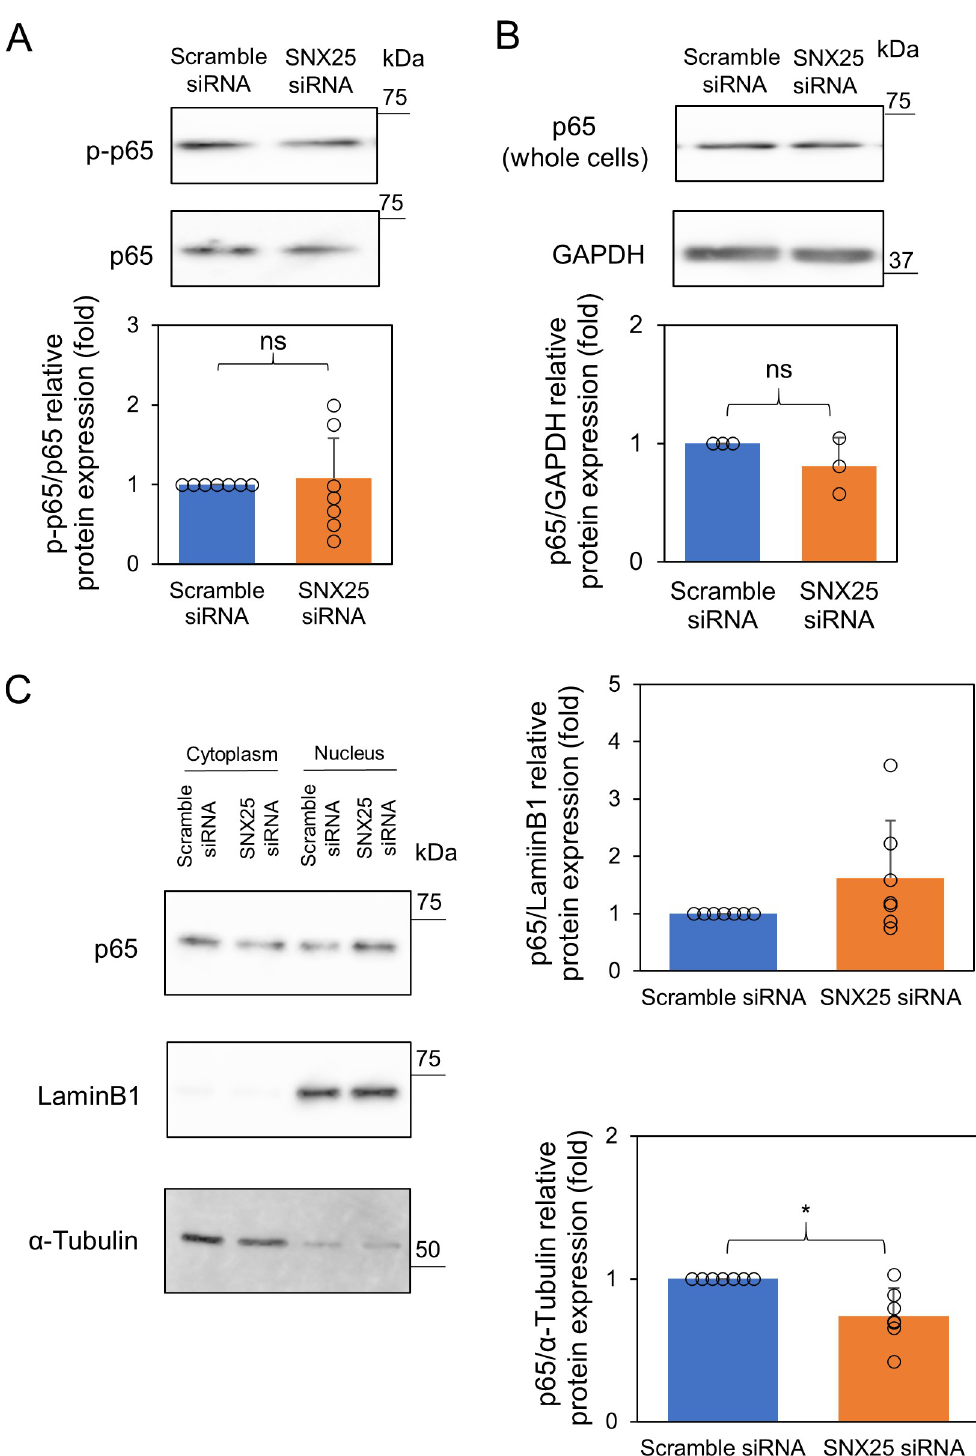
Fig 4. Activation of NF- κ B signaling pathways in SNX25 knockdown RAW 264.7 cells. (A) RAW 264.7 cells were stimulated with LPS (1 μ g/ml) for 10 min. p-p65 expression was analyzed by Western blotting. p65 was used as a loading control. Circles indicate the individual experimental values. Data are expressed as means ± SD. n = 7. (B, C) RAW 264.7 cells were stimulated with LPS (1 μ g/ml) for 30 min. The expression of p65 in whole cells, cytoplasm and nucleus was analyzed by Western blotting. GAPDH, α -Tubulin and LaminB1 were used as a loading control. Data are expressed as means ± SD. Circles indicate the individual experimental values. � P < 0.01; ns, not significant, n = 3 (whole cells), n = 7 (nucleus and